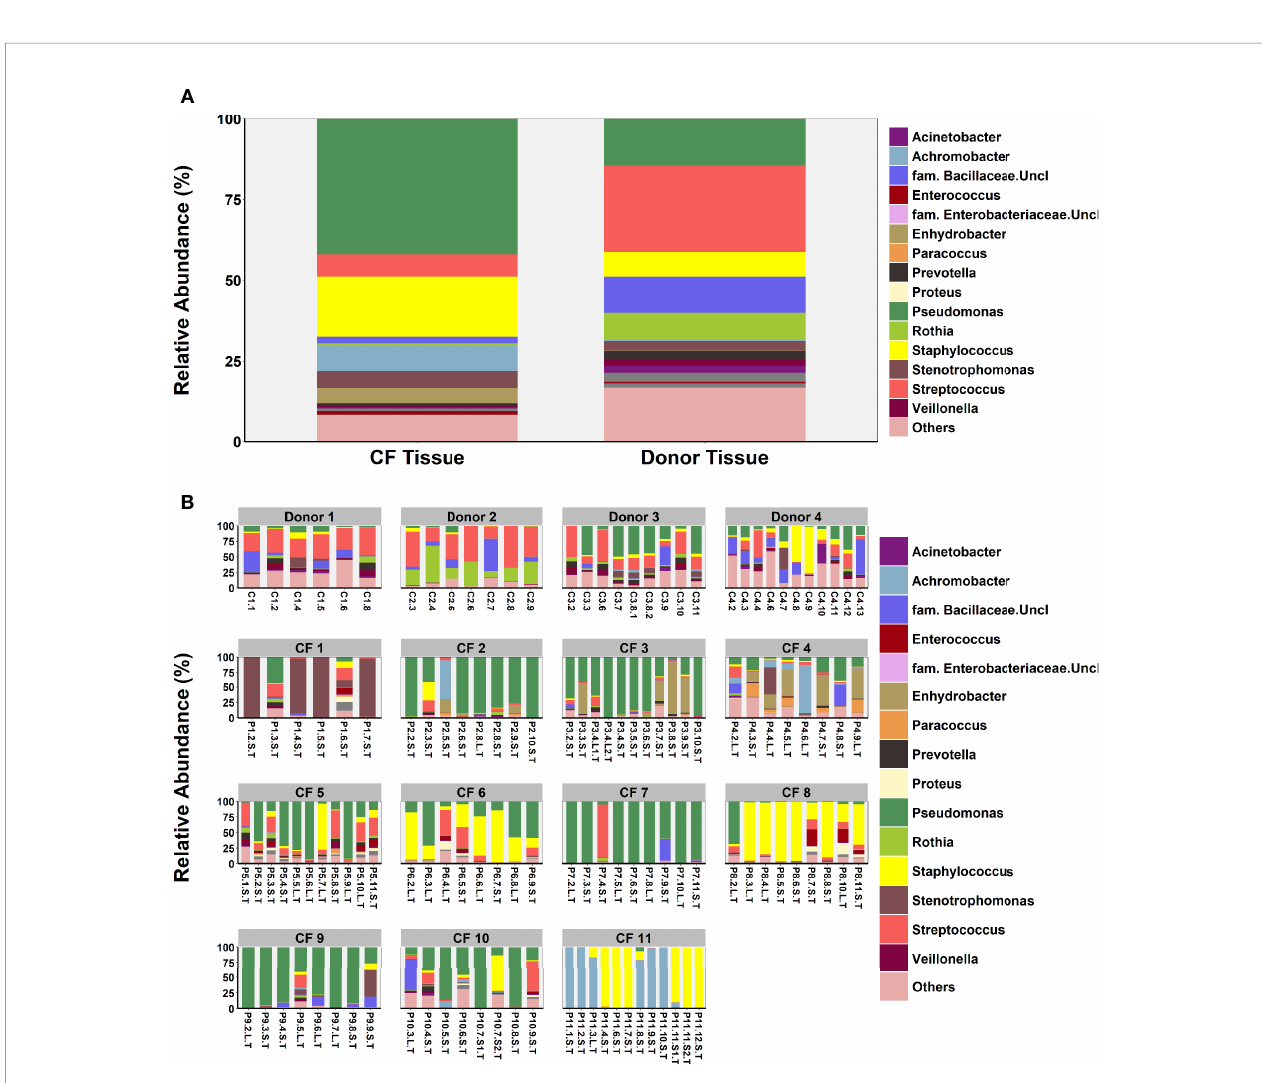
FIGURE 3 | Comparison of microbial community composition in CF (n=98 samples) and donor tissue (n=33 samples). (A) Mean relative abundance by cohort of all genera present >1% RA. (B) Mean relative abundance for individual patient samples of all genera present >1% RA. Sample names are denoted as: Px.x, patient/ lung-slice number (from apex to base); (Px.x.) S/L, small or large airway; (Px.x.S/L.) S/T, luminal mucus or